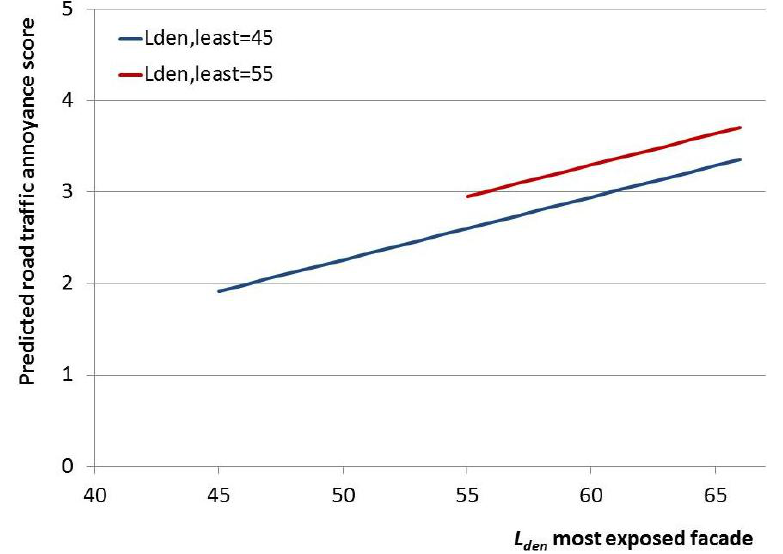
Figure 4. Road traffic noise annoyance score predicted from L L (dB, continuous). Results from linear regression den,least